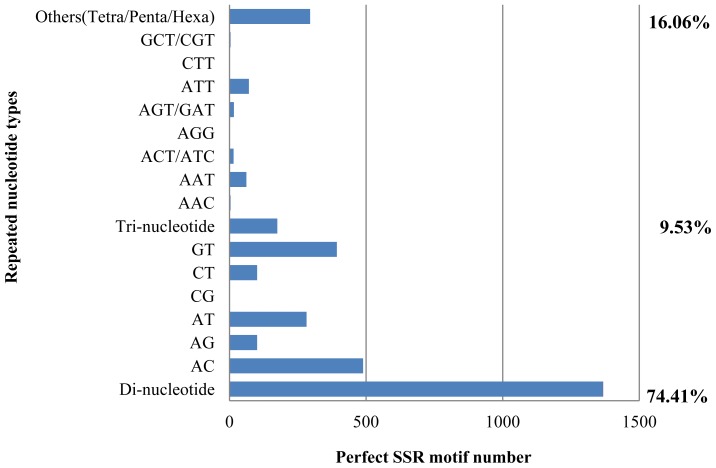
Distribution of simple sequence repeat (SSR) nucleotide classes among different nucleotide types in H. siamensis.